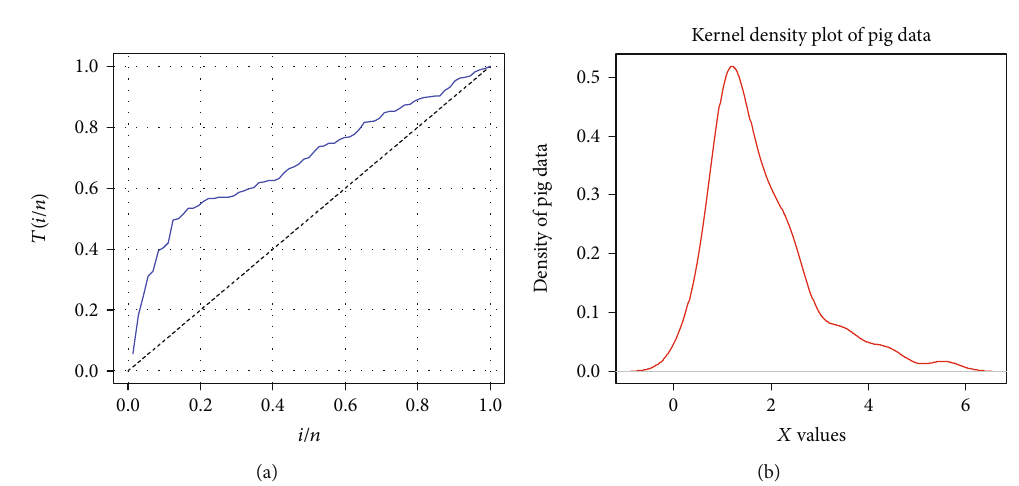
Figure 5: Graph of TTT plot and the kernel density function of the cancer